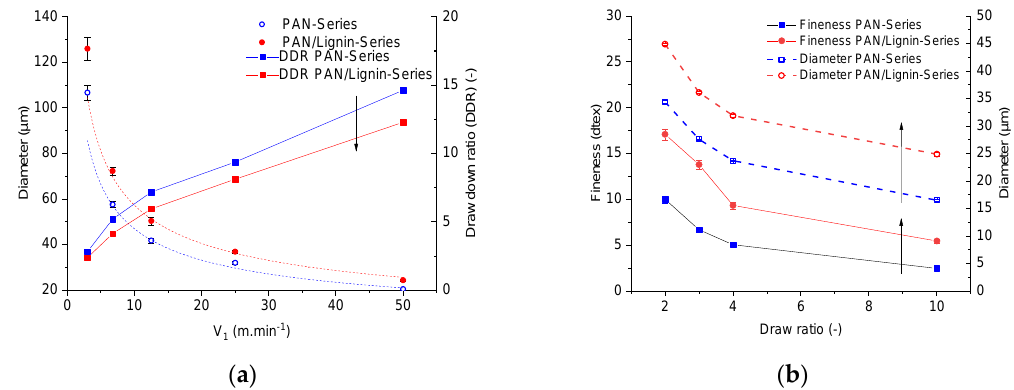
Figure 5. ( a ) The influence of the take-up speed on the diameter of the as-spun PAN and PAN/lignin fibers and on the draw down ratio (DDR). All spinning trails were conducted at 85 °C and a pump rotational speed of 0.5 rpm. ( b ) The influence of the in-line drawing and the solid-state drawing on the fineness and the diameter of the fibers (spinning conditions: V1 = 10 m·min −1 ; T = 85 °C; T C_Bath = 6 °C; pump rotational speed = 0.5 rpm).